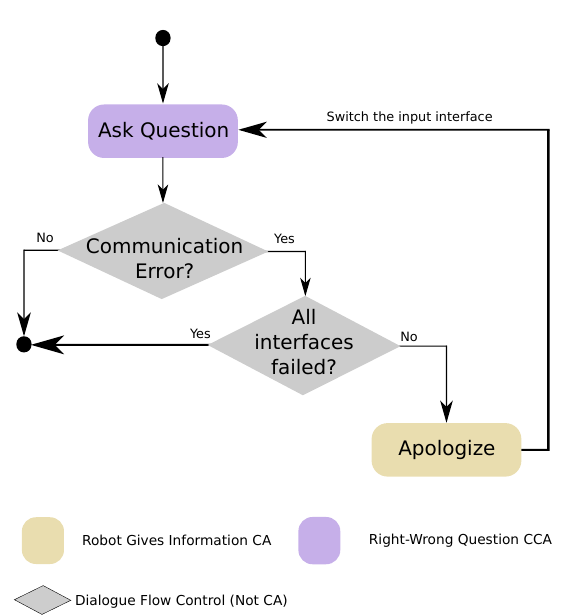
Figure 5. Flow diagram for the switching mode question CCA. This CCA can be configured with multiple input modes, and then it switches from mode to mode in case of communication problems.